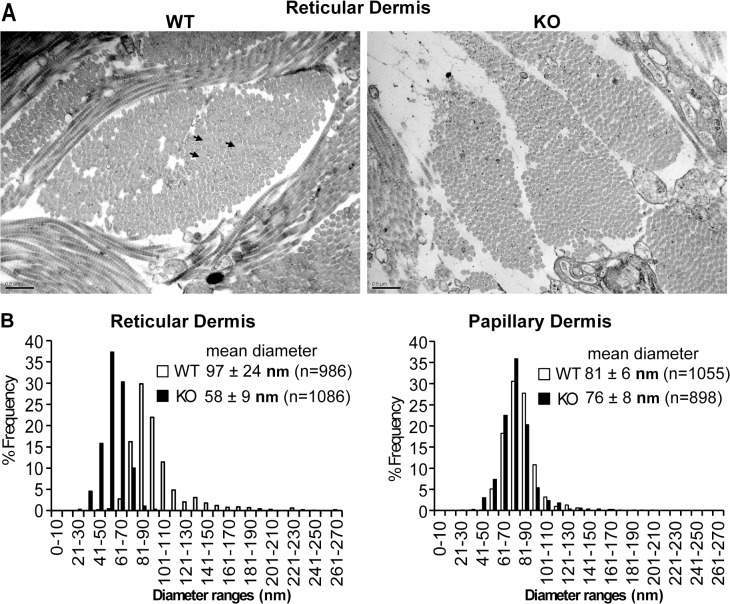
Fibril diameters in the KO reticular dermis are smaller and more uniform than WT fibrils.
A. Representative micrographs of skin in deep dermal areas near subcutaneous fat. (Scale bar = 0.5 μm) B. Histogram of the frequency of collagen fibrils with a given diameter range from WT (white bars) and KO (black bars). At least 200 fibrils from 3 WT and 3 KO animals at 5 months of age were used for analysis. P<0.05.